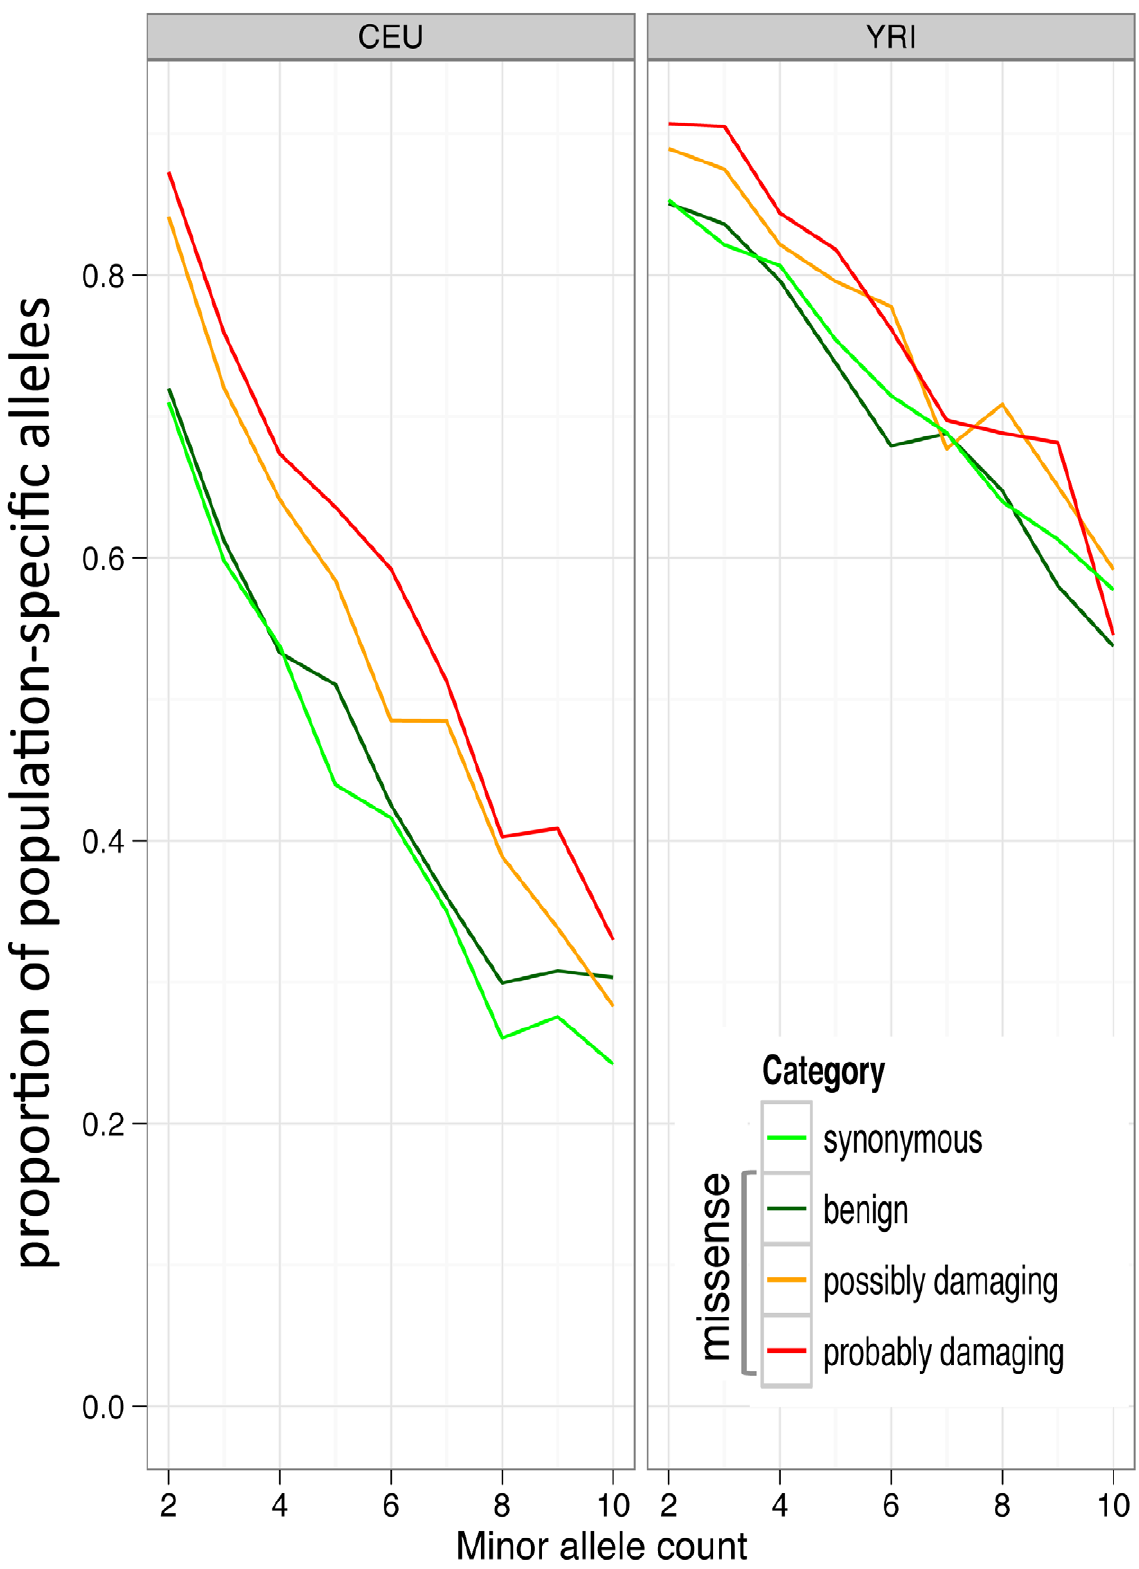
Figure 7. Allele frequency spectra and population-private coding alleles. The graphs show the proportion of population-private synonymous alleles and non-synonymous alleles stratified by PolyPhen-2 functional predictions.